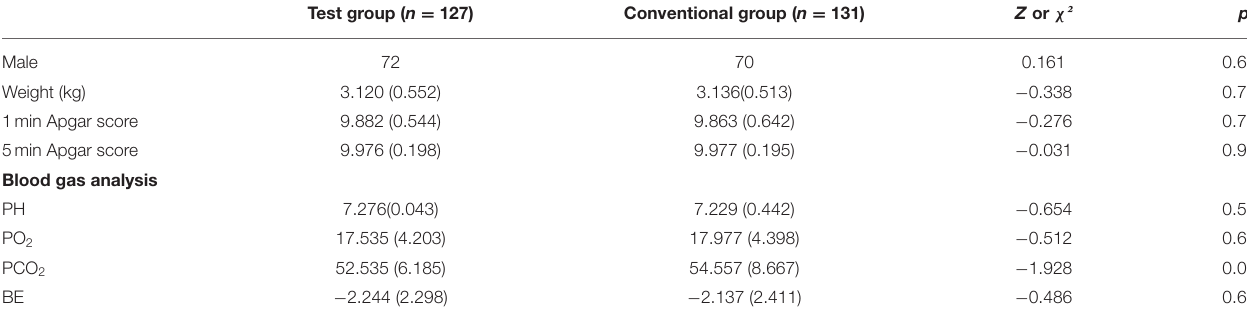
TABLE 7 | Neonatal